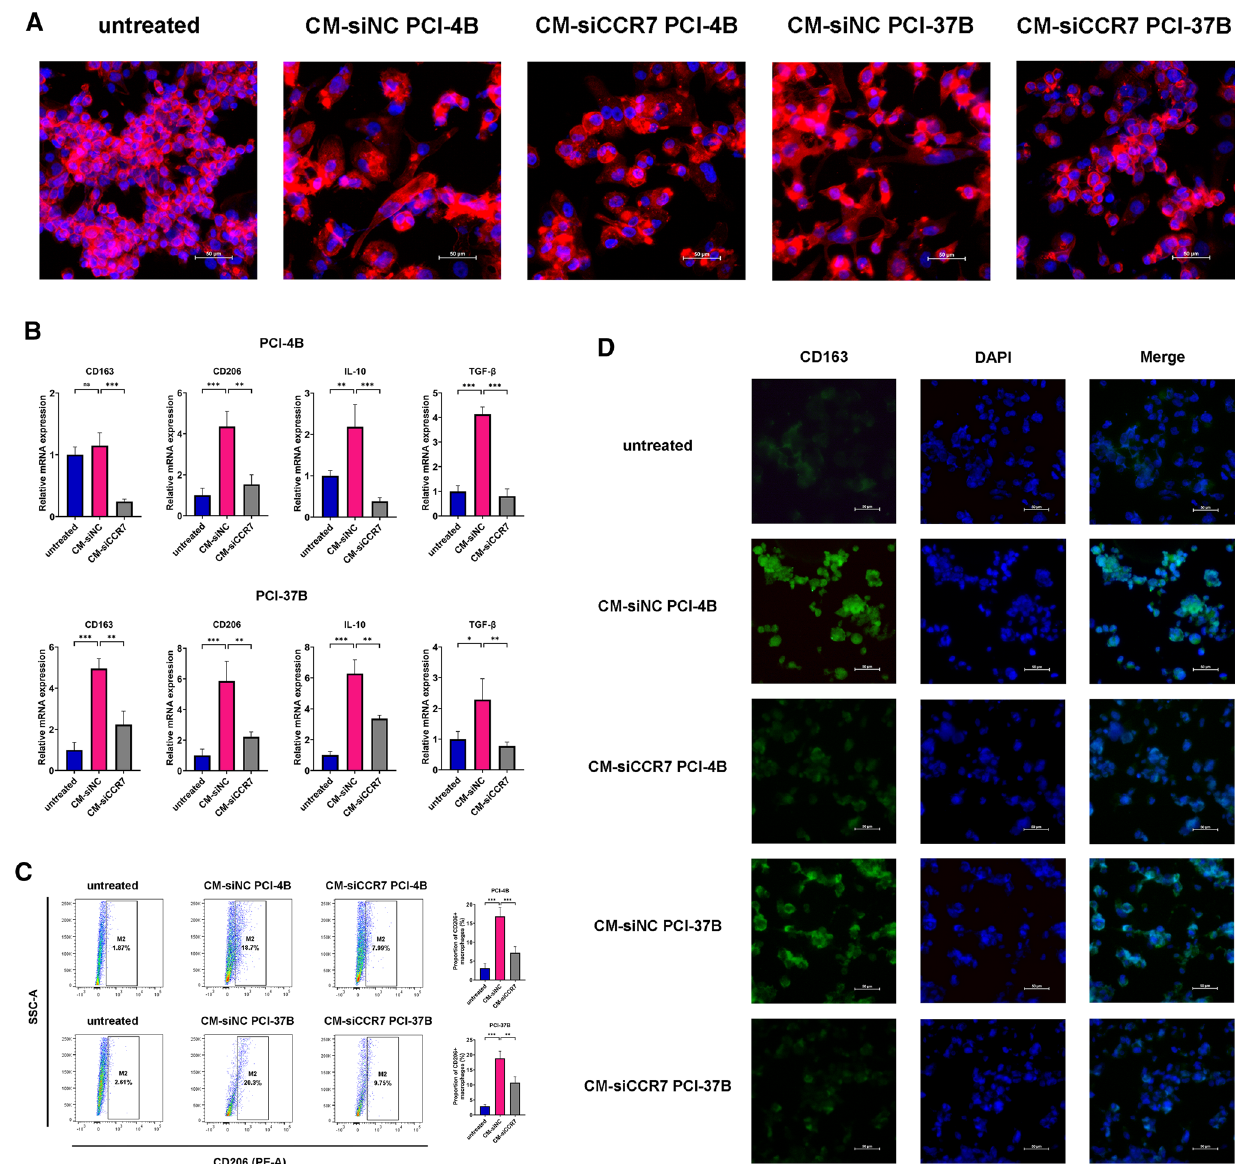
Fig. 3 Knockdown of CCR7 in OSCC cells suppressed macrophage M2-polarization. A Representative morphological images of THP-1 derived macrophages cultivated with OSCC CM. The cytoskeleton was labelled with Actin-Tracker Red-555 Fluorescent Phalloidin (red), and nuclei were stained with DAPI (blue) (scale bar: 50 μm). B The mRNA expression level of CD163, CD206, IL-10 and TGF-β1 of macrophages co-cultured with OSCC CM, evaluated by qRT-PCR. C Representative Scatter plots showed the CD206 expression level of macrophages incu- bated with OSCC CM, measured by flow cytometry. The histogram displayed statistical analysis for the proportion of CD206+ macrophages. D Representative fluorescent images of macrophages treated with OSCC CM. The cytomembrane CD163 was labelled with Alexa Fluor® 488 (green), and nuclei were stained with DAPI (blue) (scale bar: 50um). The results are presented as the mean ± SD, ns: not significant, * P < 0.05, ** P < 0.01, *** P <